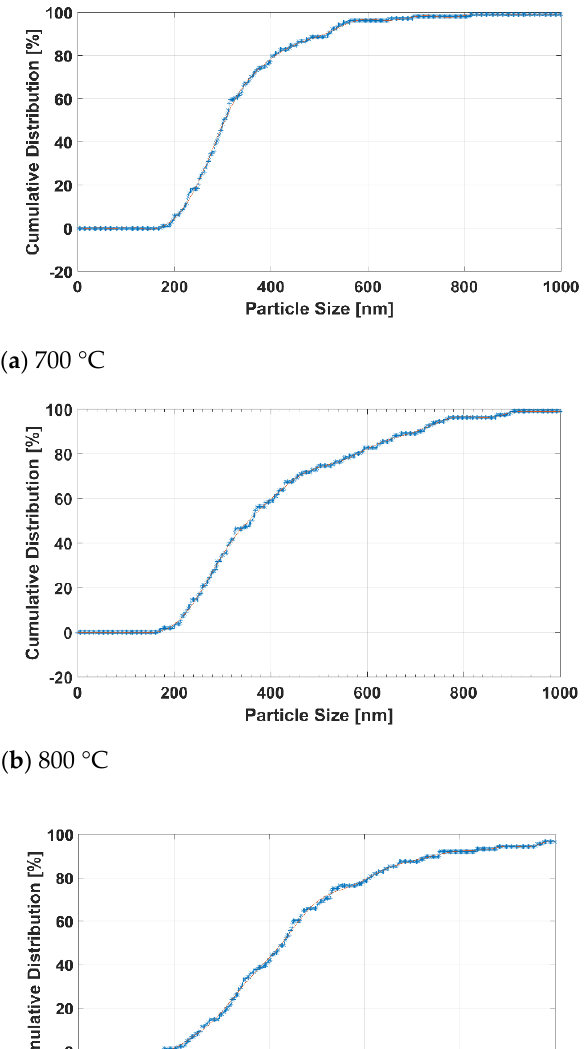
new circles at the three boundary points. Then, the center of the circle is computed, with the junction point of new circles and diameter limits defined by the user. After the detecting RE-oxide nanoparticles, these particles were labelled with blue rough circles and their cumulative distribution results related to process conditions were achieved. The results are given in Figure 10.